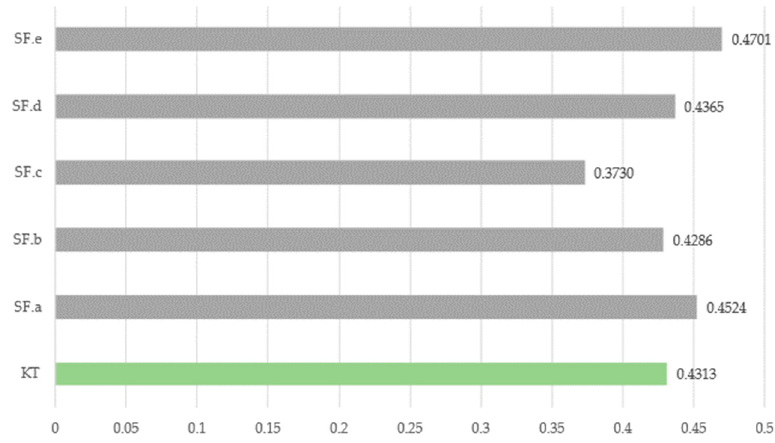
Figure 5. Performance of the SIT in the KT function and sub-functions.